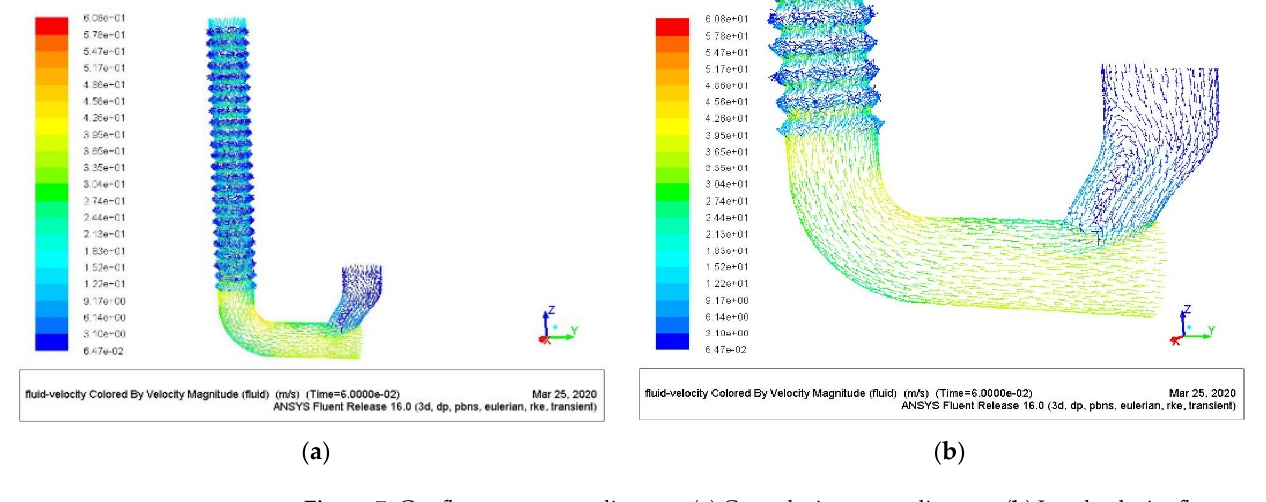
Figure 7. Gas flow rate vector diagram. ( a ) Gas velocity vector diagram; ( b ) Local velocity flow vector diagram of injector nozzle position.